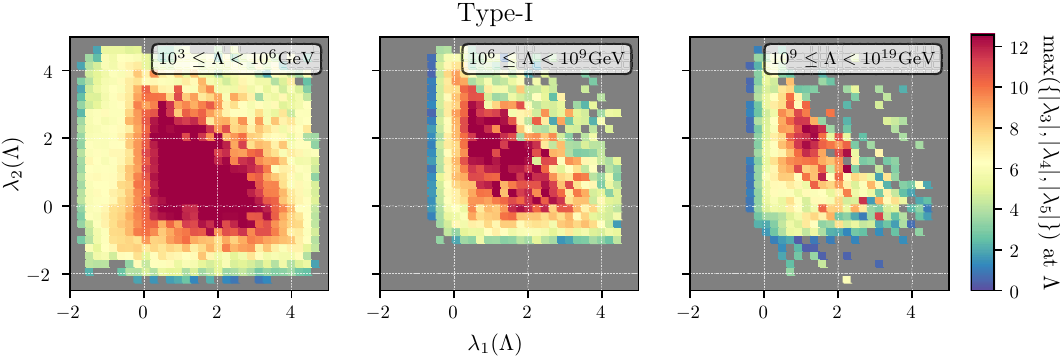
Fig. 3 The per-bin maximal value of {| λ 3 | , | λ 4 | , | λ 5 |} as a function of λ 1 and λ 2 at the matching scale. In the plots from left to right, we show three different ranges of the matching scale. We use Yukawa textures of type-I for this